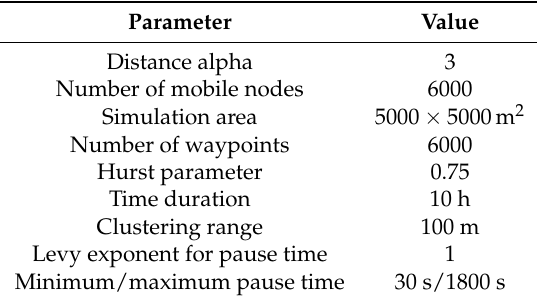
Table 1. Parameter settings of SLAW